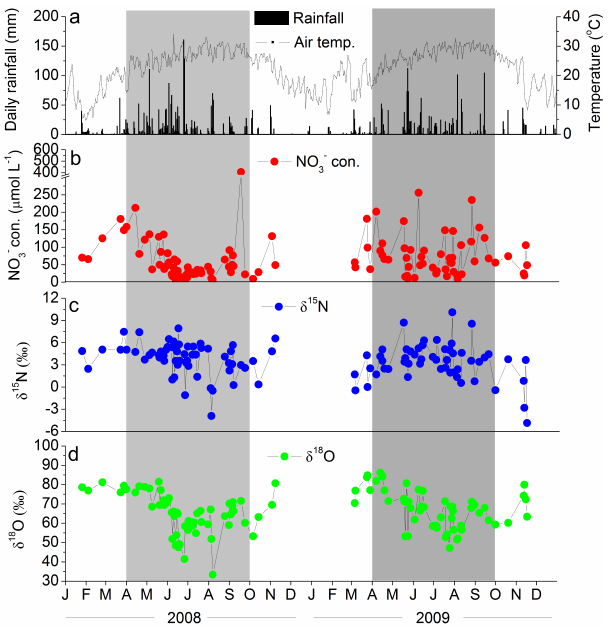
Fig. 2. Daily precipitation and mean air temperature (a) , NO − con- 3 centration (b) , δ 15 N-NO − (c) , and δ 18 O-NO − (d) in precipitation 3 3 from 2008 through 2009 in Guangzhou City. The shaded areas de- note the warm seasons from April to